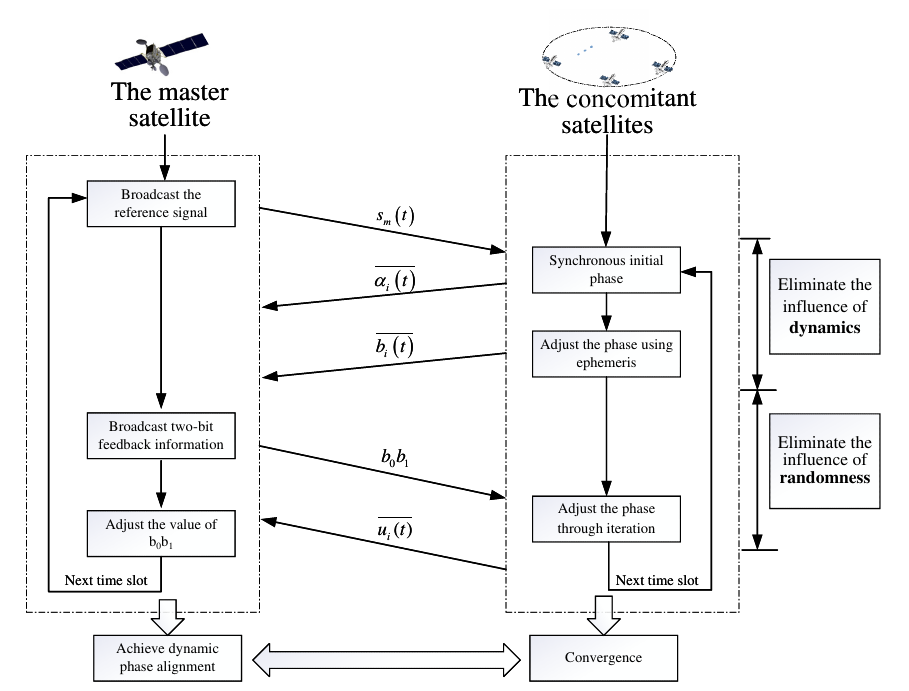
Figure 2. The two-stage phase alignment frame diagram for SS_DSC